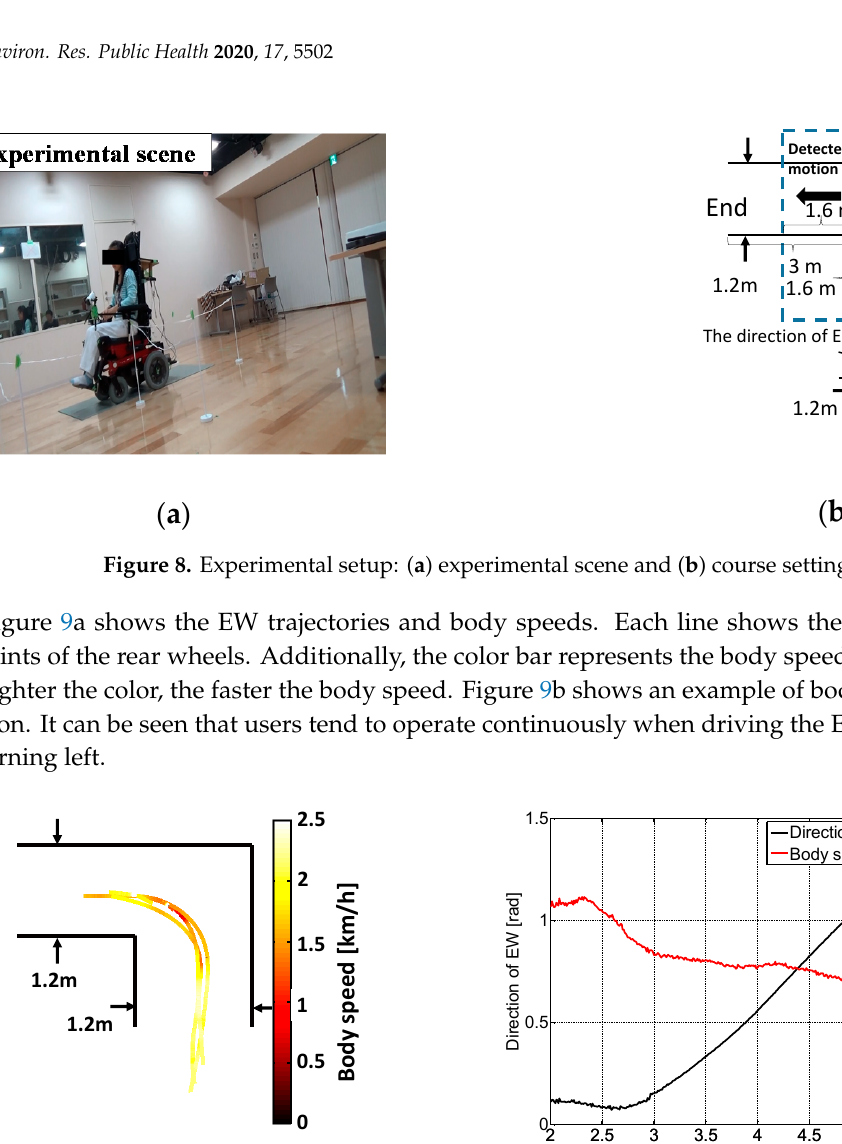
Figure 9. Experimental results of the driving characteristics: ( a ) trajectories and body speeds and ( b ) motion of an EW.